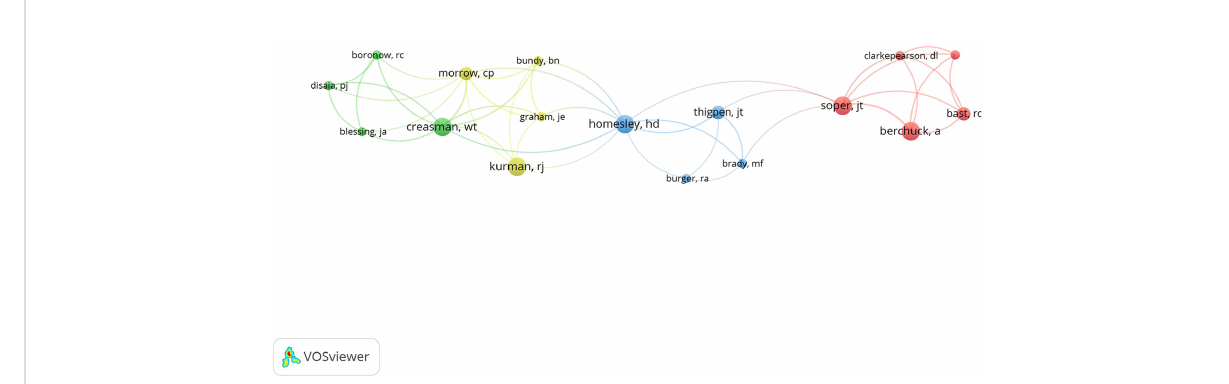
FIGURE 4 Network visualization map showing the co-authors of the top 100 most cited